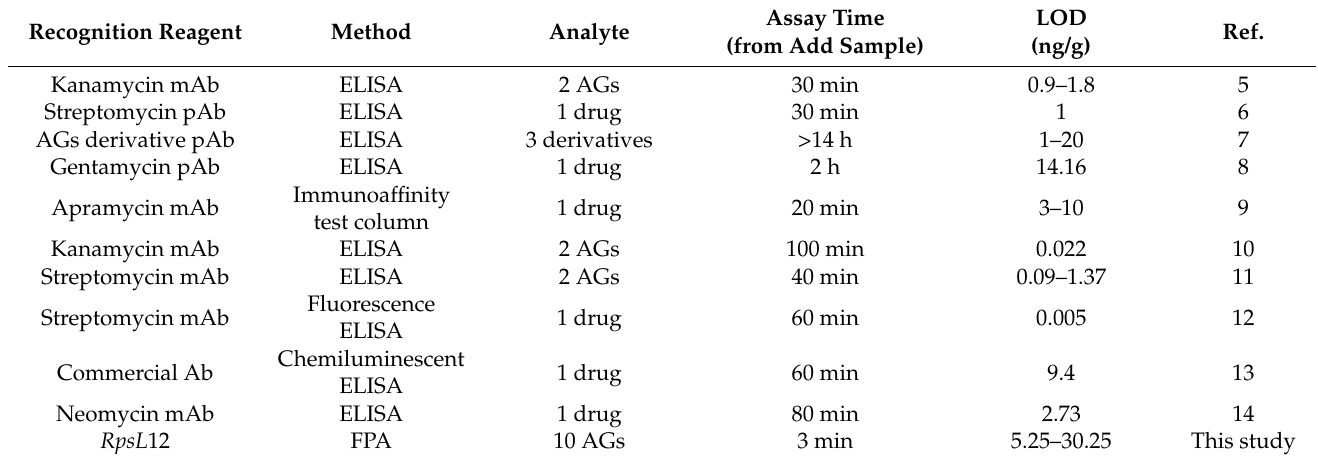
Table 3. Comparisons with some previous immunoassays for detection of